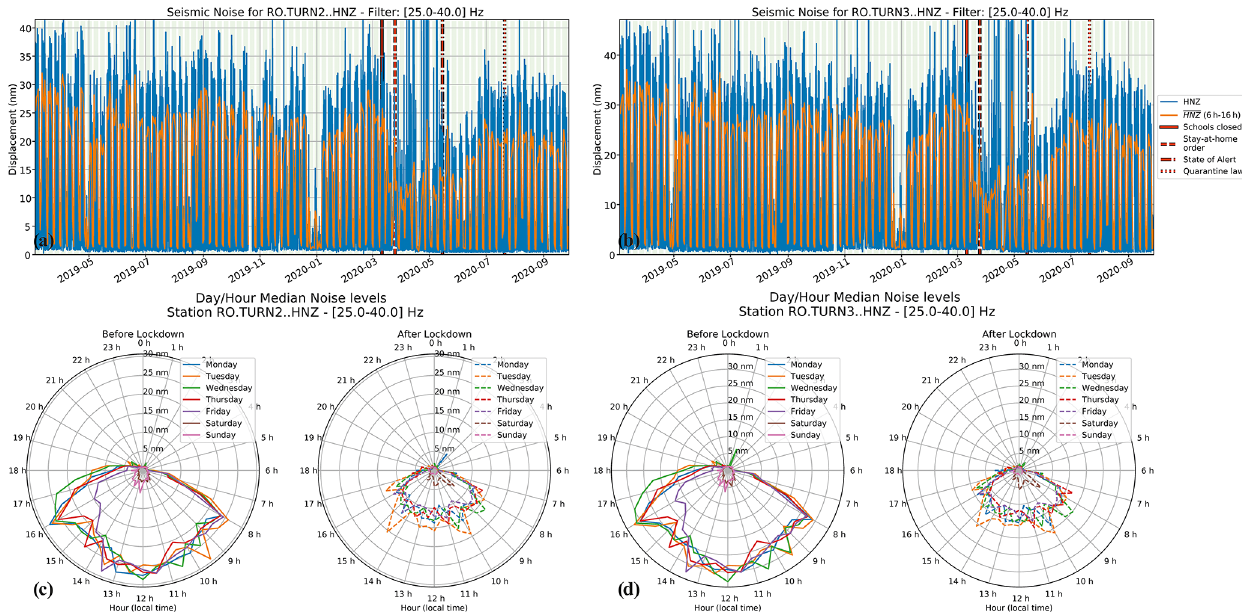
Figure 10. Temporal changes in seismic noise observed at the station located on the sixth (a) and 10th (b) floors of the IAP building. Lockdown effects are shown on 24h clock plots for both stations in (c) and ( d ) (see Fig. 1 for the station locations).